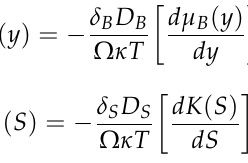
7 of 25 Figure 3. Fracture morphology of the sample: ( a ) Macro fracture picture of the interface, ( b ) SEM- SE micrograph of crack surface inside the Nb container, ( c ) SEM-SE micrograph of crack on the surface of TiAl sample. 4. Discussion 4.1. The Source of the Force Based on the analysis in Section 3, the crack is always transgranular while its location changes with the evolution of interface morphology, which is very different from other SCC. Based on the previous study [54], three IMC layers consisting of many small and parallel columnar crystals with a certain surface curvature formed on the surface of Nb container, as shown in Figure 4. This interfacial configuration has instability, which is co-